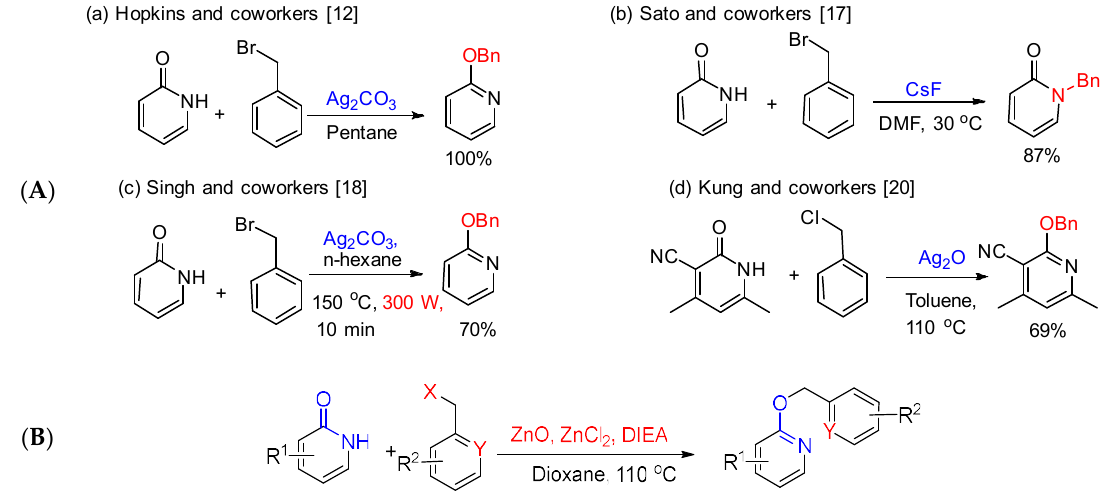
Scheme 2. Metal-mediated benzylation of ambident anions. ( A ) Previous work about benzylation of